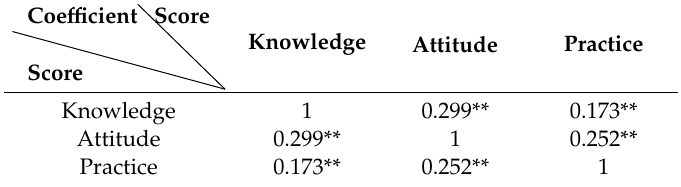
Table 6. Correlation analysis between knowledge score, attitude score, and practice score. ScoreCoe ffi cient Score